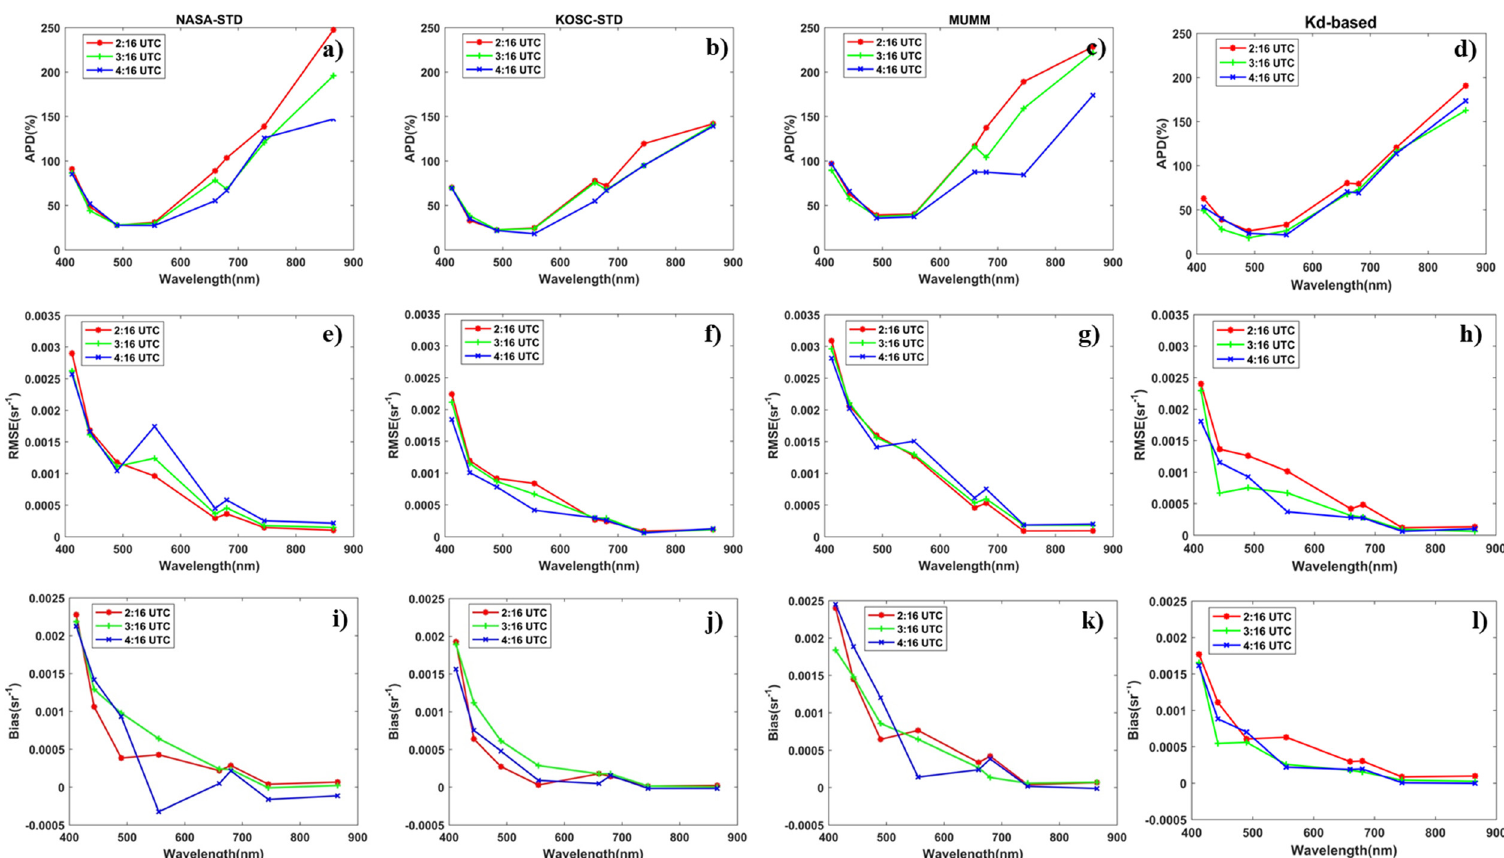
Figure 5. APD (%, upper row), RMSE (sr − 1 , middle row), and Bias (sr − 1 , lower row) of Rrs per period (02:16, 03:16, 04:16 UTC) and per algorithm (from left to right column: NASA-STD, KOSC-STD, MUMM, and Kd-based methods) as a function of wavelength at ± 3 h. Red, green, and blue solid lines represent the GOCI scenes at 02:16, 03:16, 04:16 UTC, respectively.